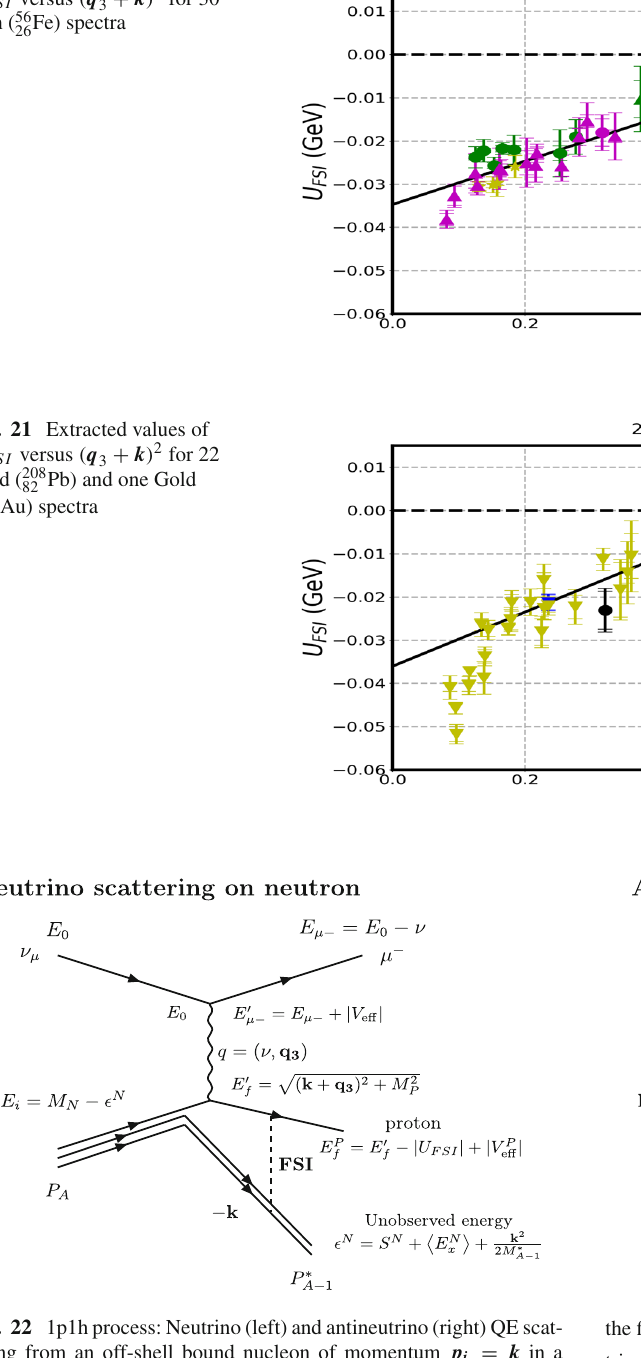
Fig. 20 Extracted values of U FSI versus ( q 3 + k ) 2 for 30 Iron ( 56 Fe) spectra 26